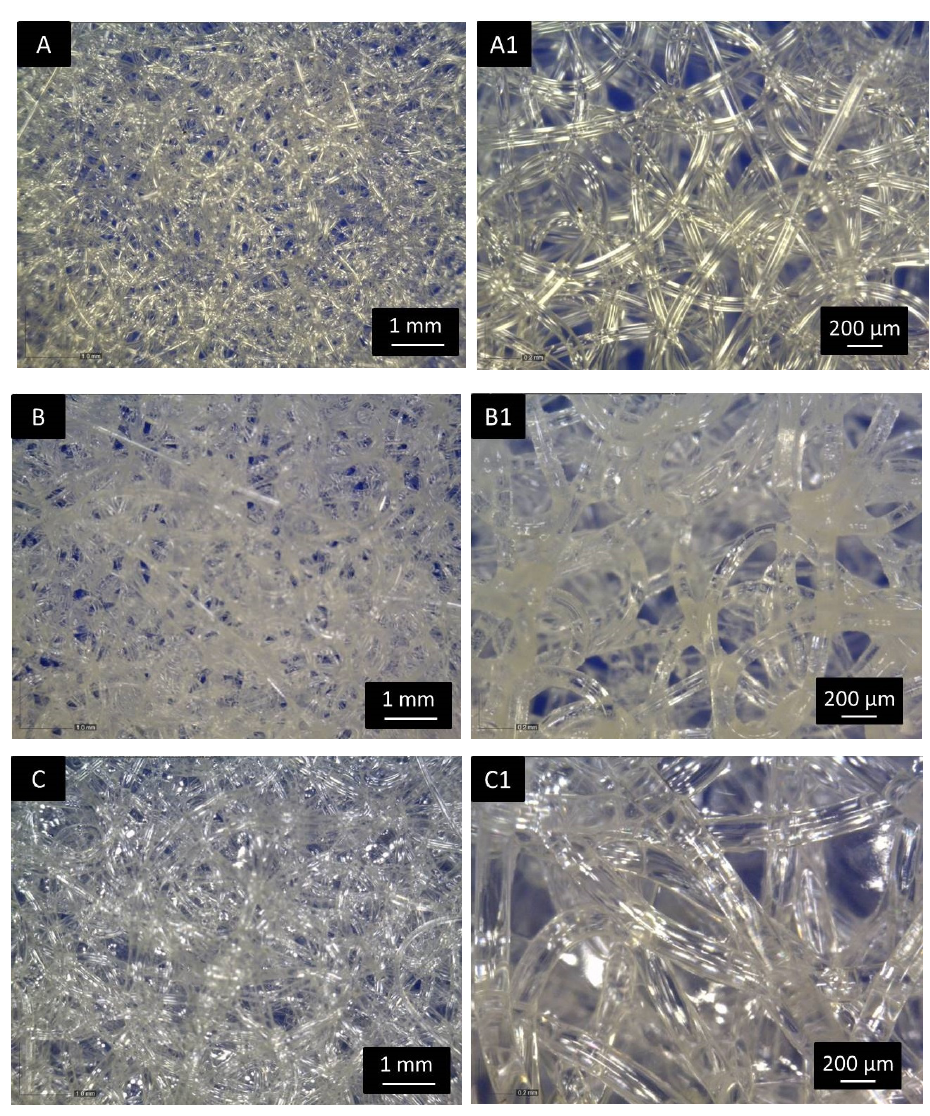
Figure 4. Optical images (magnifications 60× and 200×) of the electrospun melt ( A , A1 ) PLA, ( B , B1 ) PLA/silk fibroin, and ( C , C1 ) PLA/gelatin scaffolds. PLA/silk fibroin, and ( C , C1 ) PLA/gelatin